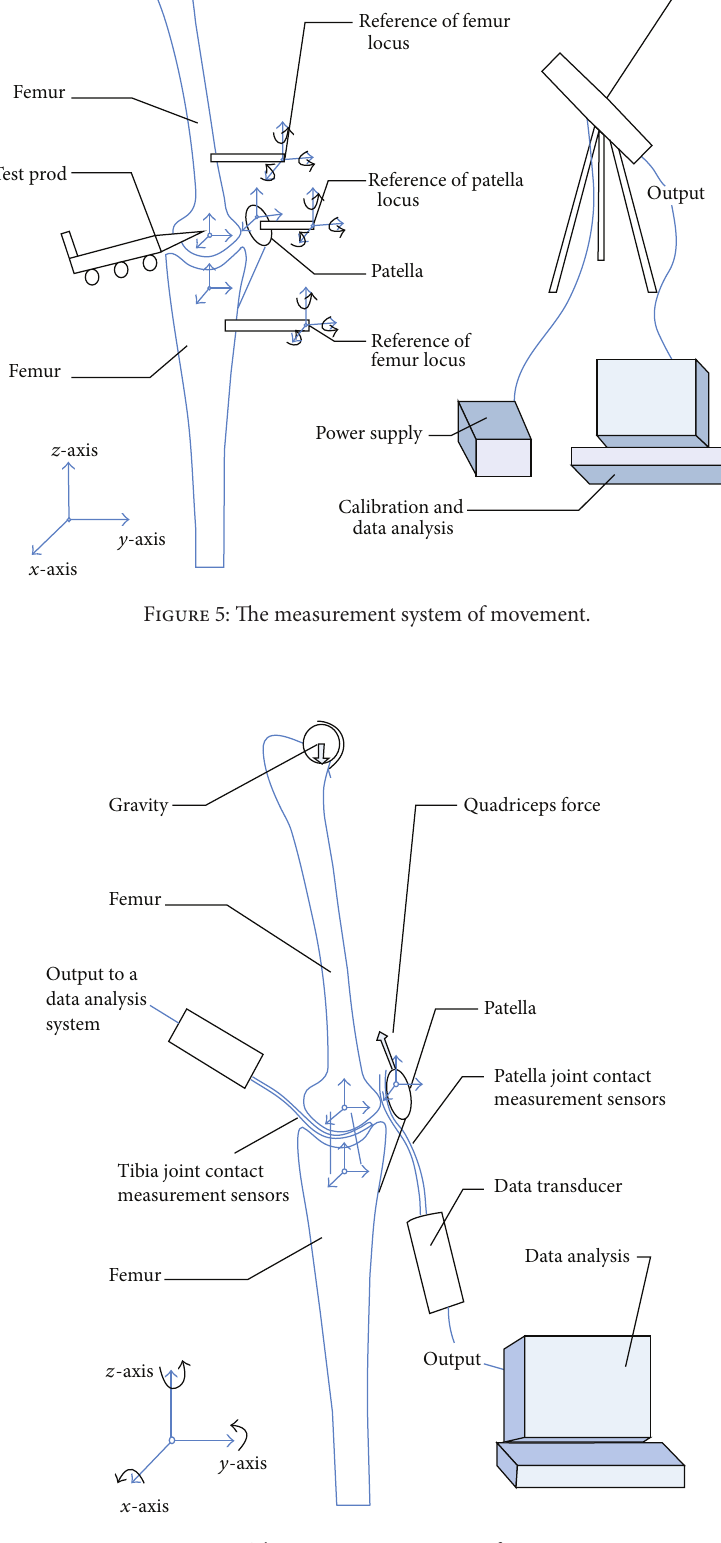
Figure 6: The measurement system of